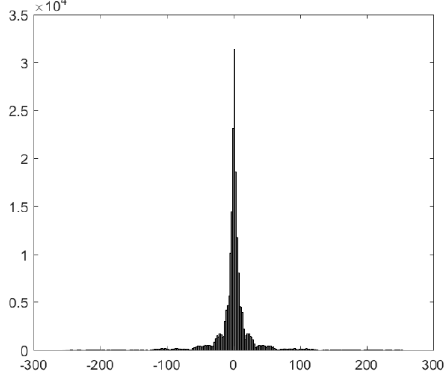
Figure 3. The histogram of the pixel differences of Lena.